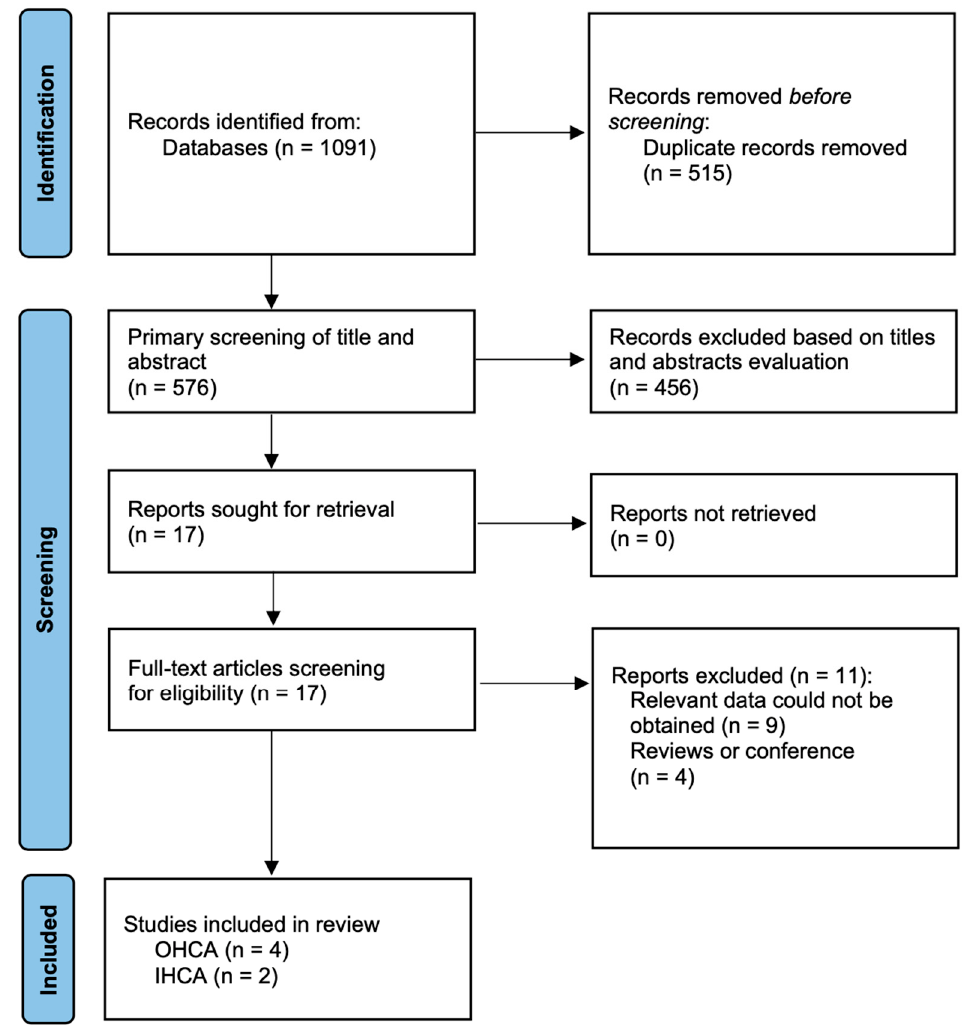
Figure 1. Flow diagram of the search strategy and study selection. Legend: IHCA: in-hospital cardiac arrest; OHCA: out-of-hospital cardiac arrest. Table 1. Characteristics of included trials.